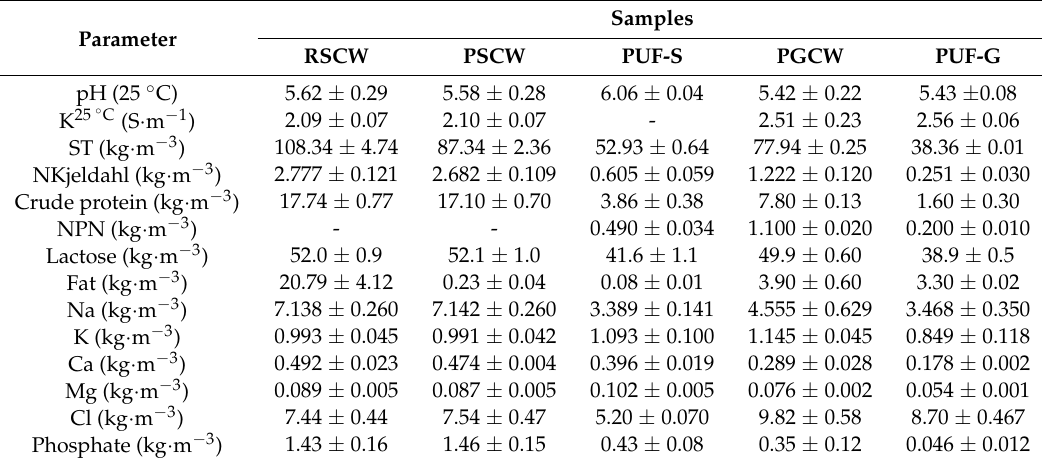
Table 2. Physicochemical characterisation of sheep and goat cheese whey 1 (average values ± 95% confidence